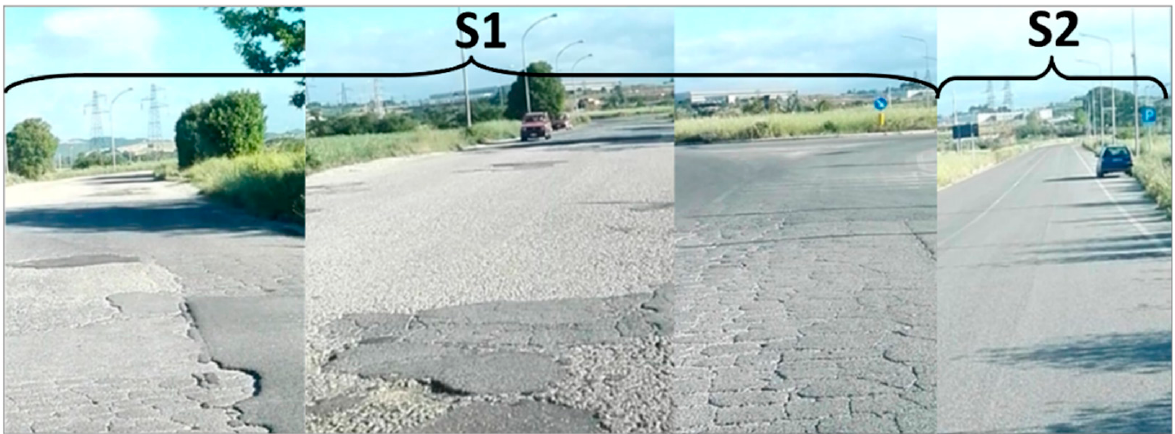
Figure 3. Alligator cracking, potholes, and patching all long Section 1 and non-distressed Section 2.